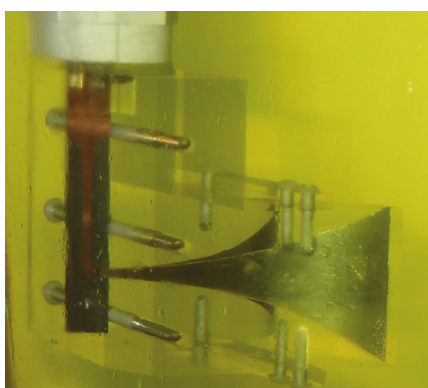
Figure 5: Implemented TEM horn.